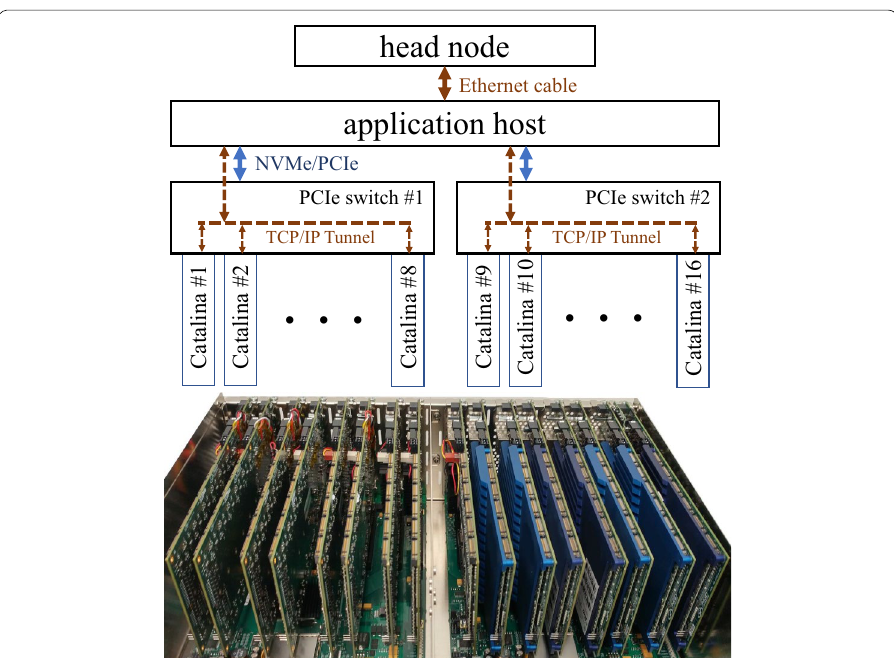
Fig. 9 Architecture of the developed platform equipped with 16 Catalina CSDs